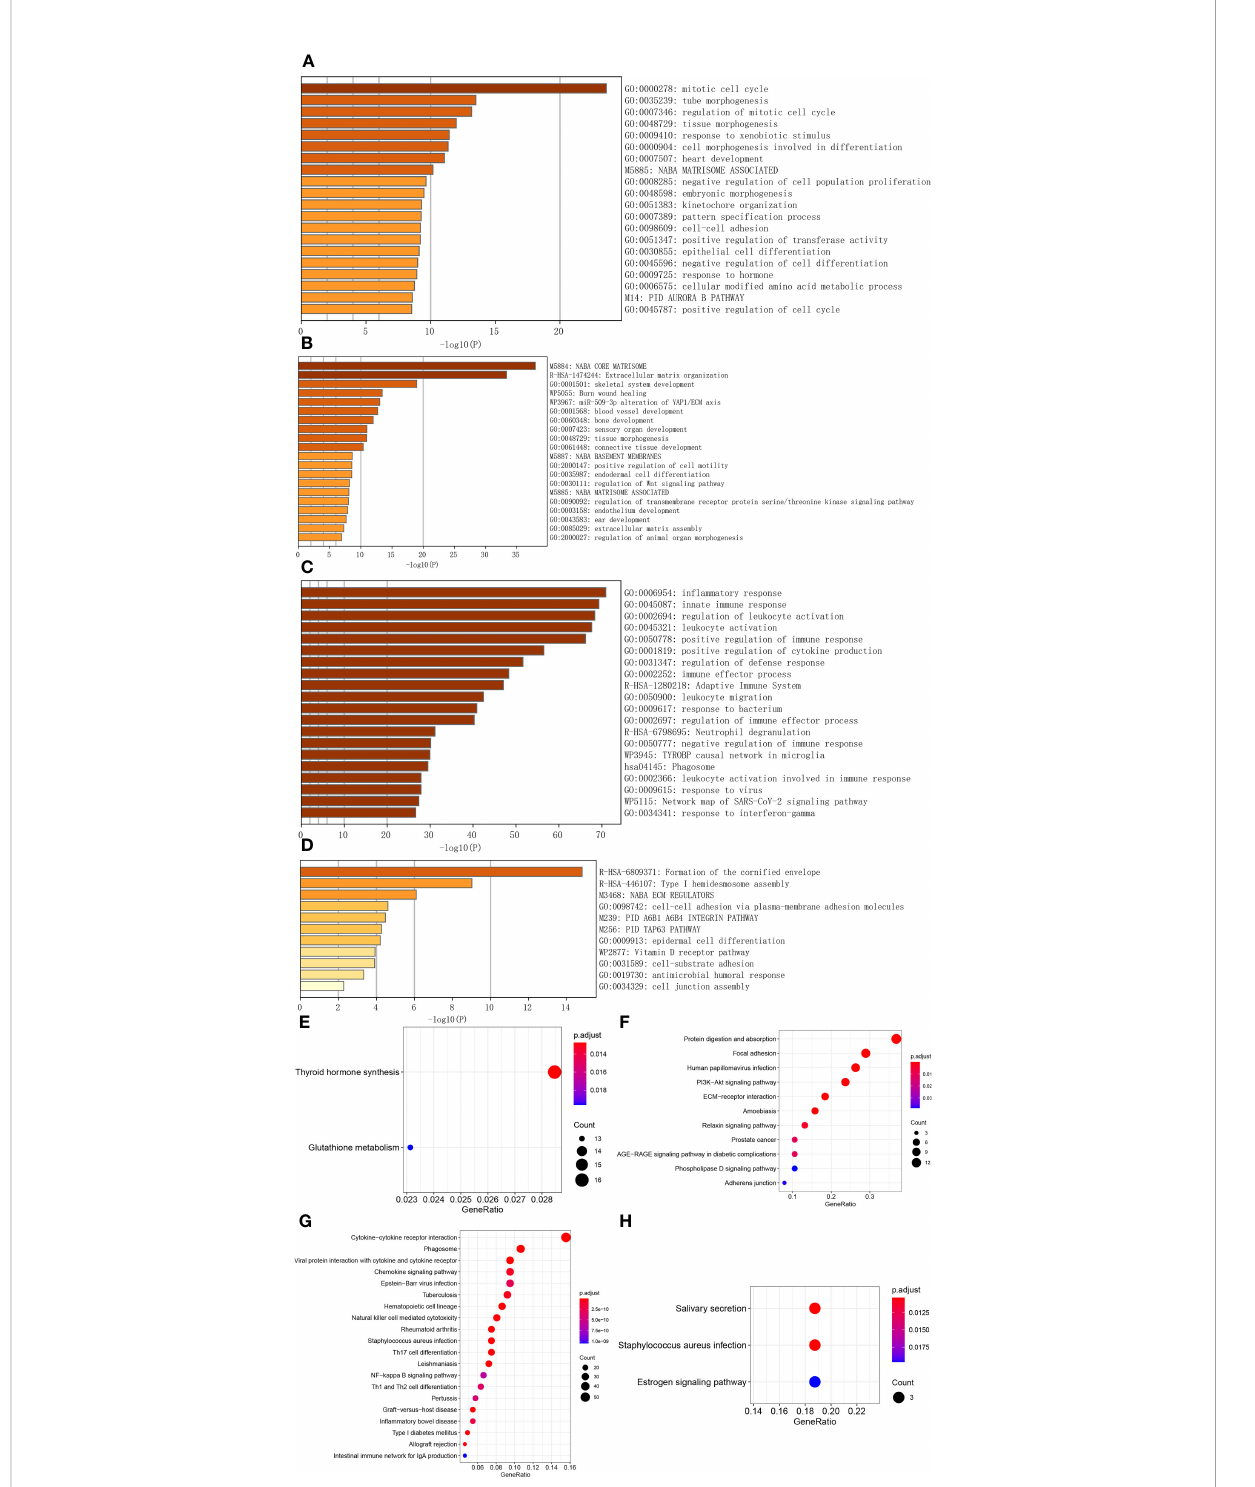
FIGURE 2 Function and pathway analyses of hub genes in ATC-speci fi c modules. (A – C) The top 20 biological signals or pathways signi fi cantly enriched by hub genes of turquoise, magenta, and blue module, respectively. (D) All biological signals or pathways signi fi cantly enriched by the hub genes of the purple module. (E – H) KEGG pathways signi fi cantly enriched by hub genes of turquoise, magenta, blue, and purple module, respectively, among which, the top 20 pathways were shown for the blue